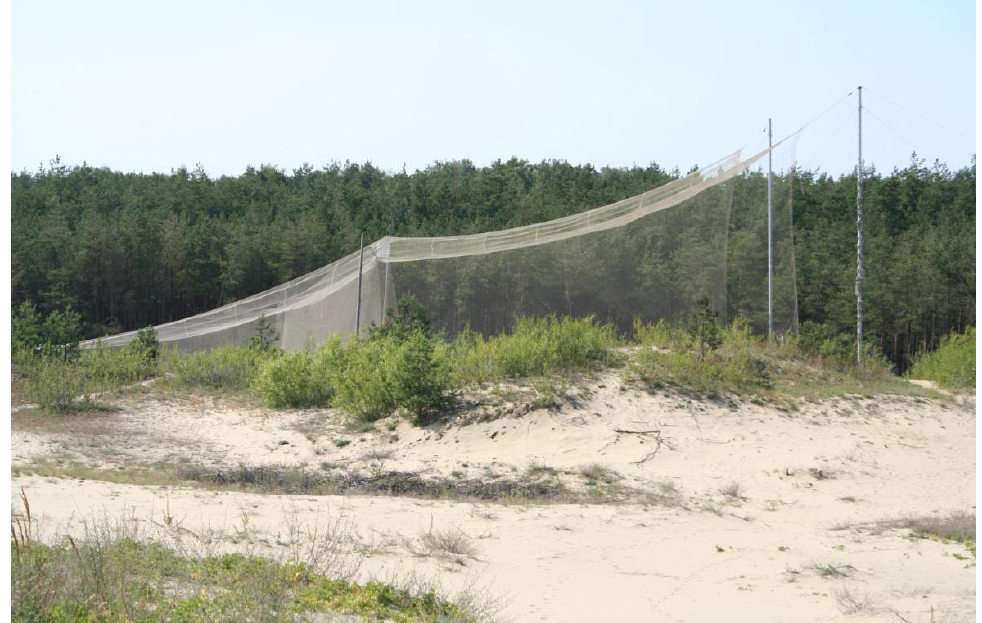
Рис. 2. Внешний вид и месторасположение большой стационарной ловушки «рыбачинского типа»